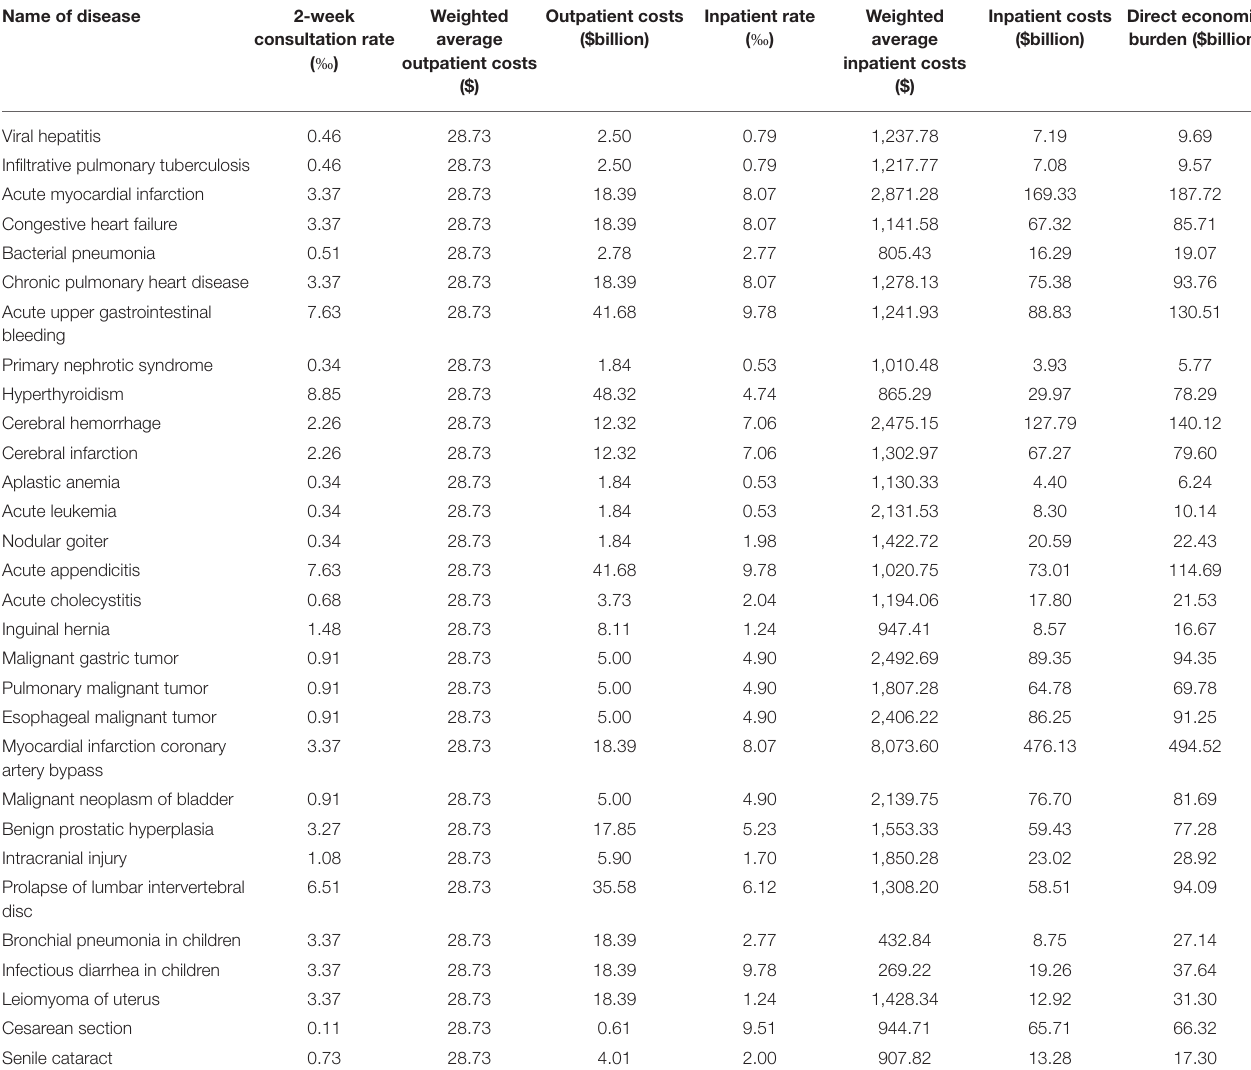
TABLE 1 | Direct economic burden of 30 types of diseases in urban areas in China in 2013. Name of